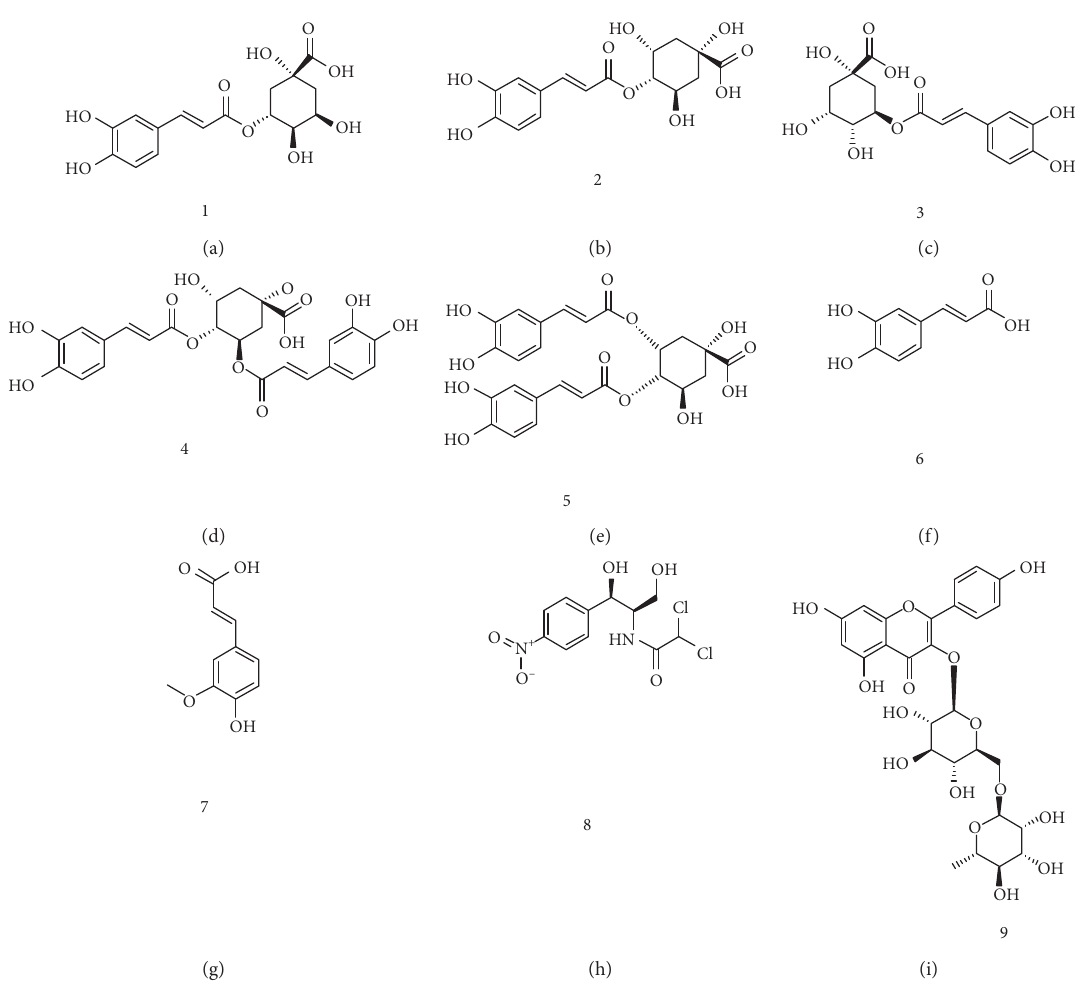
Figure 1: Compound structures of (a) chlorogenic acid, (b) cryptochlorogenic acid, (c) neochlorogenic acid, (d) isochlorogenic acid B, (e) isochlorogenic acid C, (f) caffeic acid, (g) ferulic acid, (h) rutin, and (i) chloramphenicol